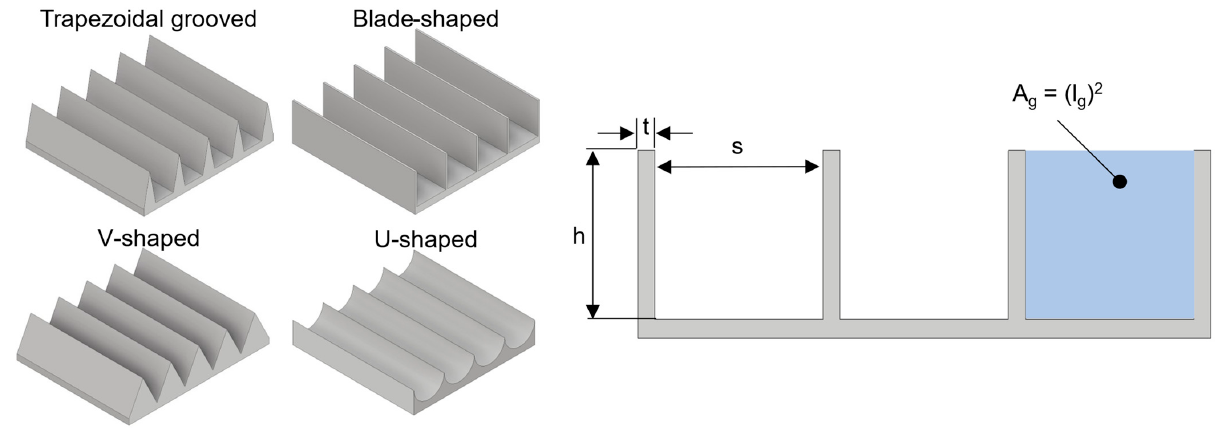
Figure 1. Different riblet geometries that have previously been investigated ( left ) and basic geometric parameters ( right ).